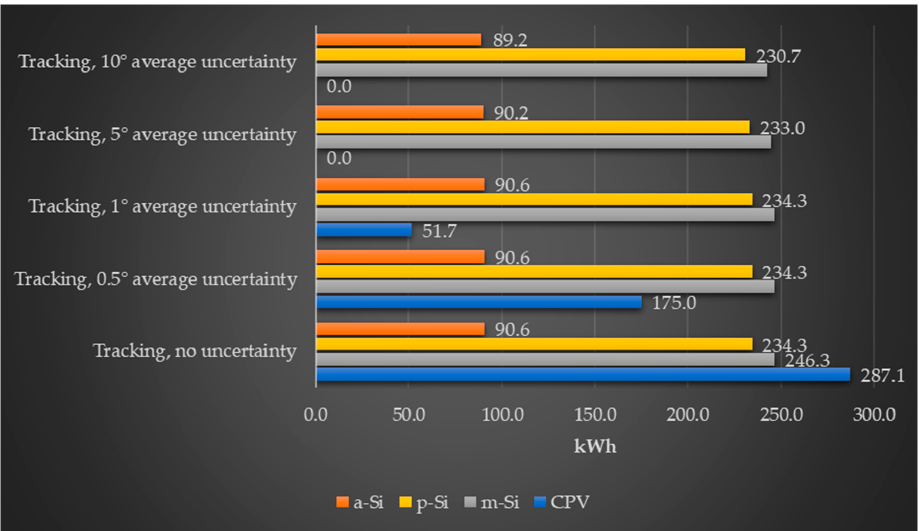
Figure 13. The yearly yields calculated for 2018 for 4 different technologies (CPV, a-SI, m-Si, and p- Si). The results are shown for sun tracking systems (CPV, a-SI track, m-Si track, and p-Si track) and for fixed PV modules with inclinations of 30 degrees (a-Si 30°, m-Si 30°, and p-Si 30°) of 45 degrees (a- Si 45°, m-Si 45°, and p-Si 45°) and 60 degrees (a-Si 60°, m-Si 60° and p-Si 60°). In addition, the yields of a CPV module mounted on a sun tracker with a 0.5° tracking uncertainty (CPV 0.5° uncert.) and with a 1° tracking uncertainty (CPV 1° uncert.) are shown.